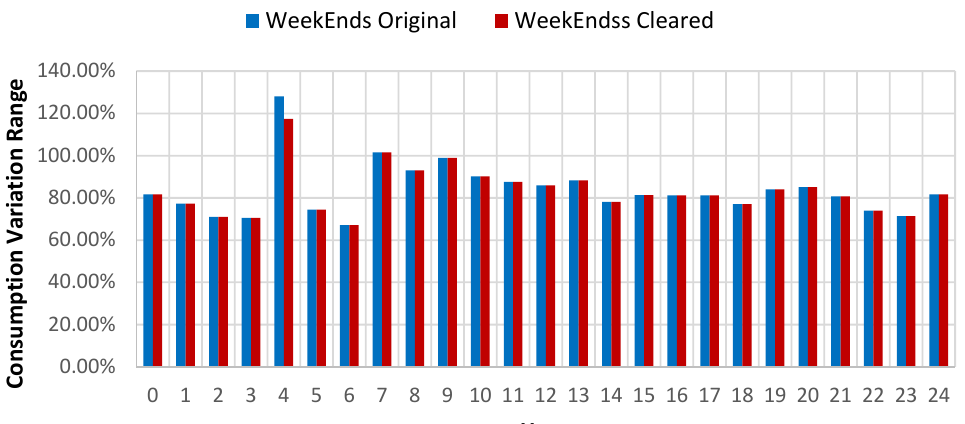
Figure 15. Energy consumption variation range compared to hourly average weekdays consumption for original and cleared data sets.